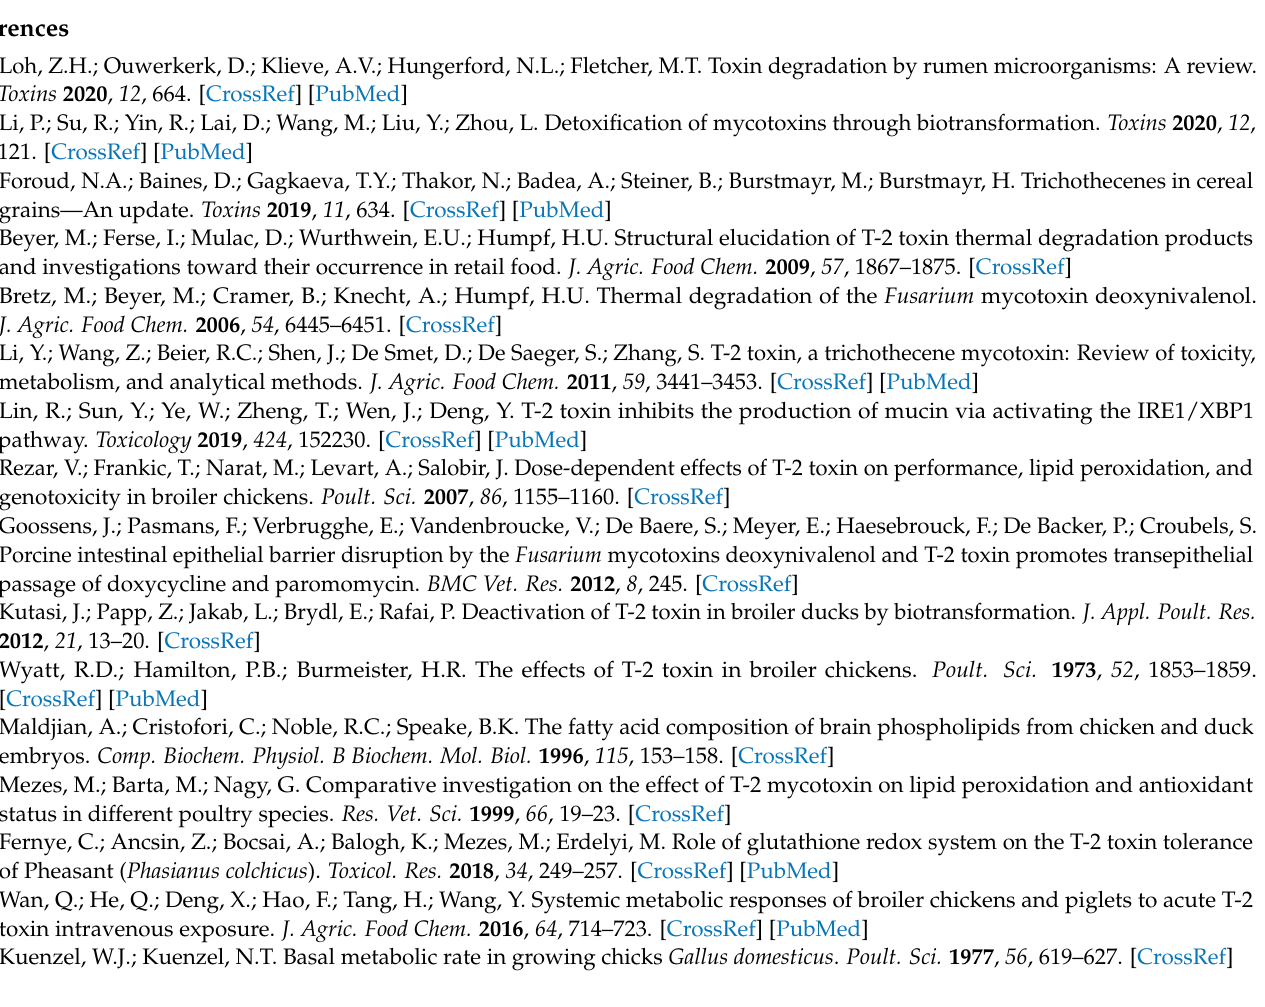
Table S5: Creatine phosphokinase activity of ducklings fed diets containing different T-2 toxin (T-2) concentrations with or without green tea powder. Table S6: Glutamate oxaloacetate transaminase activity of Brown Tsaiya ducklings and Kaiya ducklings fed diets containing different concentrations of T-2 toxin (T-2) with or without green tea powder (GTP). Table S7: Alkaline phosphatase activity Table S8: The relative weights of gizzard and leg of Brown Tsaiya ducklings and Kaiya ducklings fed diets containing different T-2 toxin (T-2) concentrations. Table S9: The relative weights of tibias (left and right) of Brown Tsaiya ducklings and Kaiya ducklings fed diets with or without green tea powder